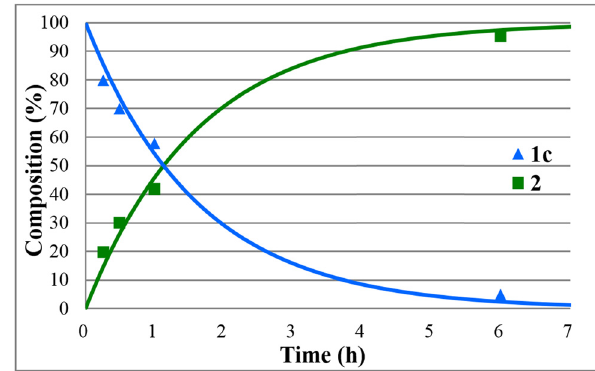
Figure 3: Concentration pro fi le for the components ( 1c and 2 ) during the hydrolysis of propyl diphenylphosphinate ( 1c ) under optimum conditions. The R 2 measure of goodness of fi t is 0.980.